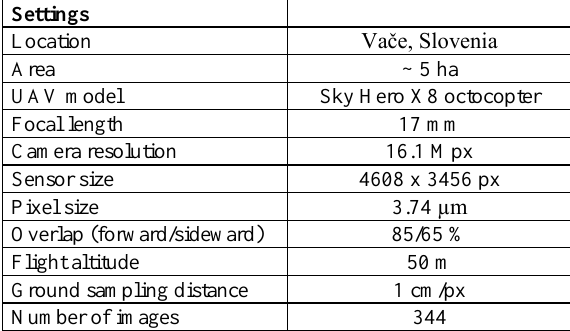
Table 1. Specification for UAV data